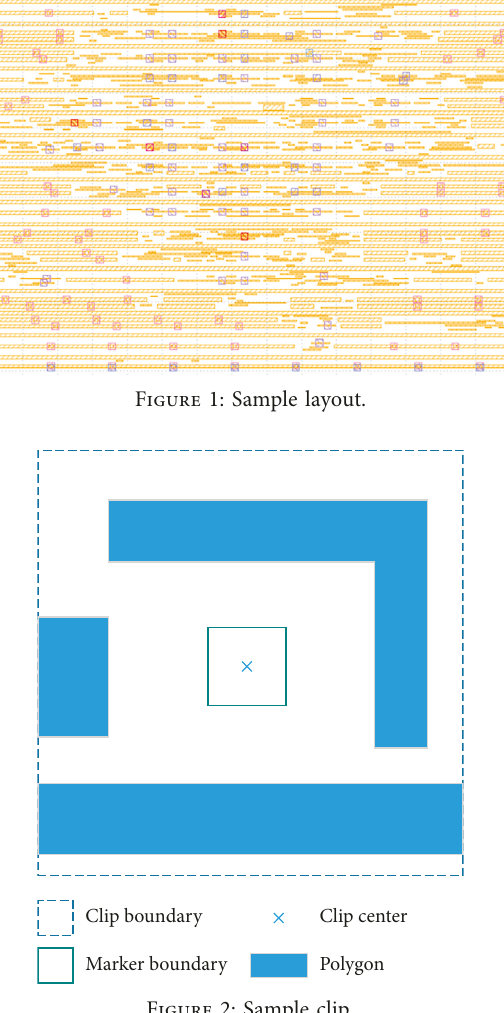
Figure 2: Sample